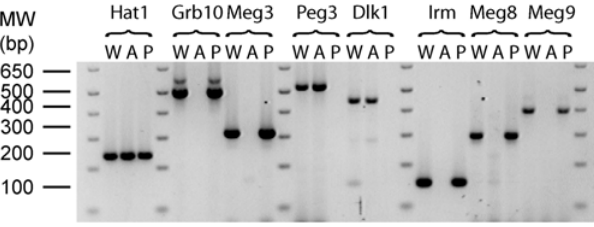
Figure 1. Androgenetic and Parthenogenetic PMEFs maintain appropriate imprinted gene expression. RT-PCR was performed on indicated PMEF cell lines: W (Wild-type), A (Androgenetic), and P (Parthenogenetic). Histone acetyltransferase 1 ( Hat1 ) is a biallelically expressed control. Dlk1 and Peg3 are controls for paternal expression while Grb10 and Meg3/Gtl2 are controls for maternal expression. With Irm primers 1307Up and 1581Dn, Irm RNA expression was undetectable in AG PMEF, while its expression was abundant in WT and PG PMEFs. Moreover, Meg8 and Meg9 , two other genes in the large imprinted gene cluster that contains Irm , have expression patterns that are consistent with being imprinted with maternal expression. The PCR primers were Hat1 510Up/758Dn, Grb10 270Up/770Dn, Meg3 267Up/578Dn, Peg3 4430Up/4956Dn, Dlk1 830Up/1274Dn, Irm 988Up/1140Dn, Meg8 1Up/ 294Dn (AF498299) and Meg9